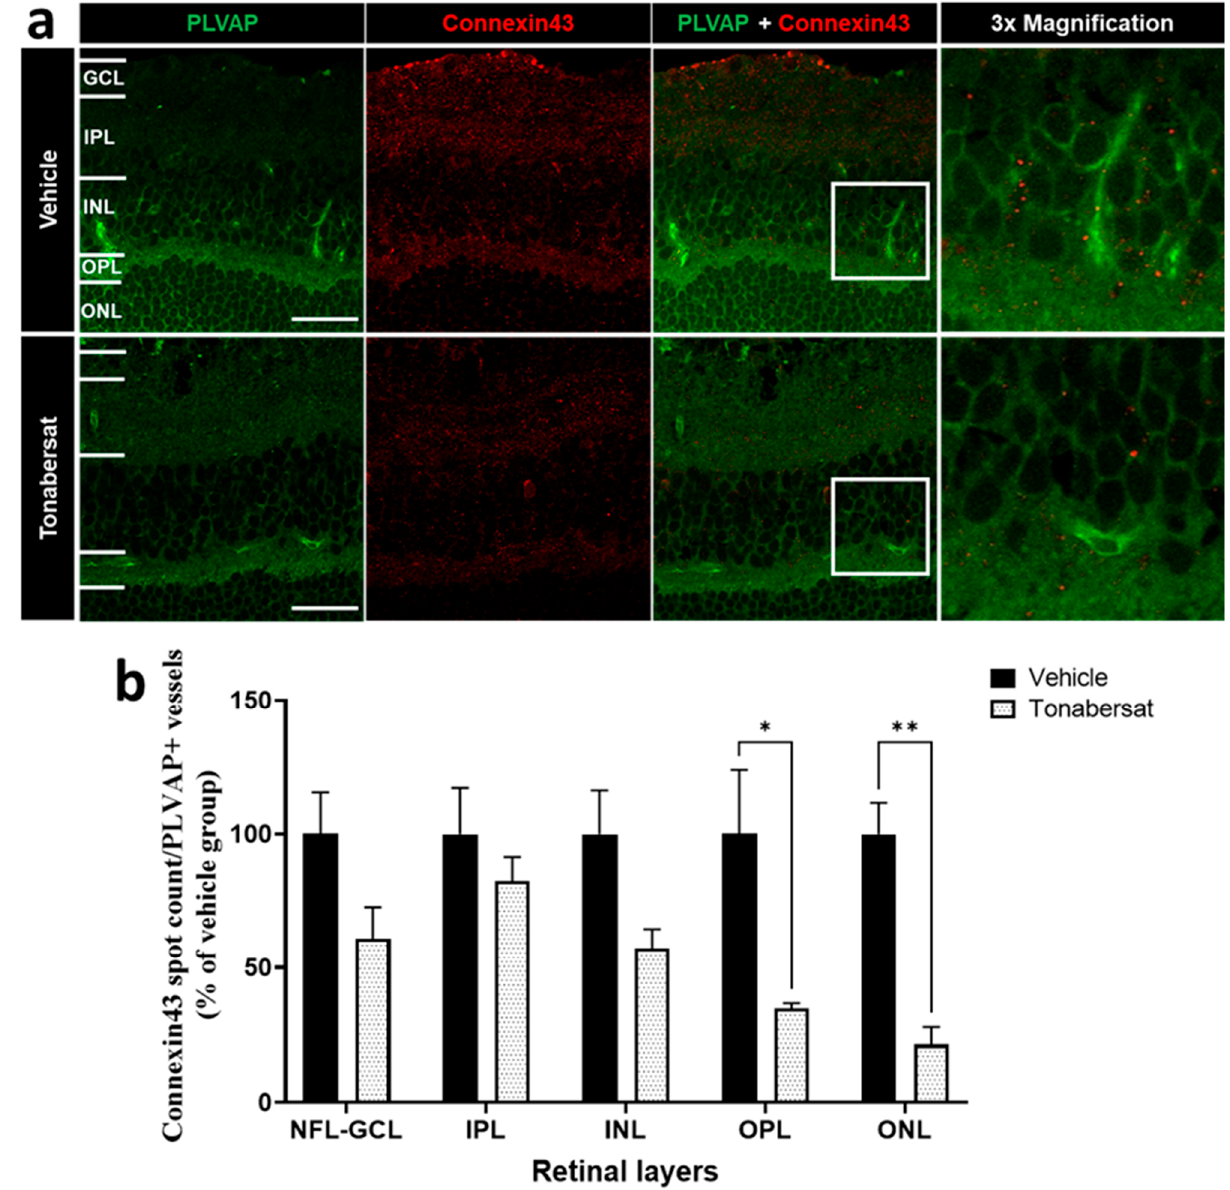
Figure 4. ( a ) Immunohistochemical images showing an example of PLVAP (green) and connexin43 (red) co-labelling. ( b ) Tonabersat treatment decreased the number of connexin43 spots on PLVAP+ vessels within the OPL and ONL but not the NFL-GCL, IPL, and INL. Data are presented as a mean + SEM. Statistical analyses were carried out using two-way ANOVA with Sidak’s multiple comparison’s test. * p ≤ 0.05, ** p ≤ 0.01. Scale bar = 50 µm. n = 8–12 eyes per group.